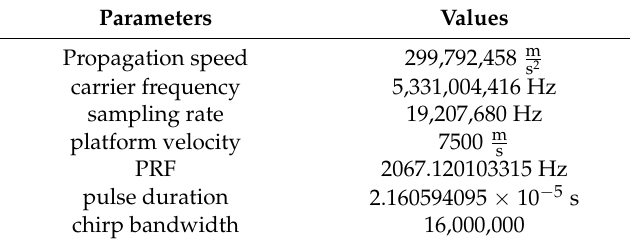
Figure 3. Reflectivity map in grayscale [39]. Table 1. Parameters of Envisat ASAR sensor.